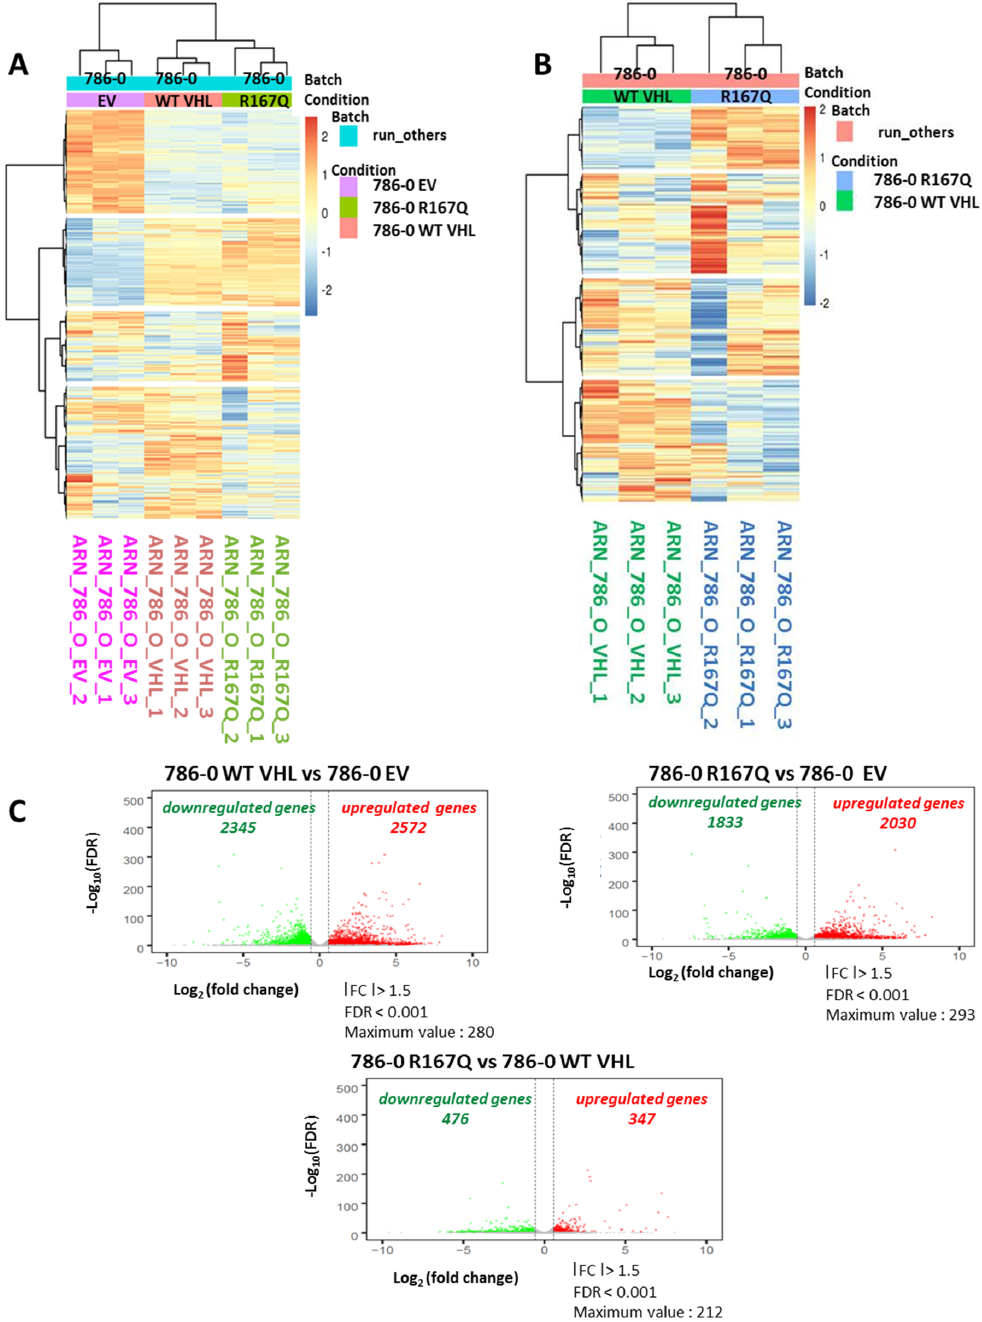
Figure 3. RNA-Seq analysis revealed discrete transcriptional differences between WT VHL and VHL-R167Q. ( A ): Heatmap from RNA-Seq analysis comparing 786-EV, 786-0 WT VHL, and 786-0 VHL-R167Q cells in triplicate. ( B ): Heatmap from RNA-Seq analysis comparing 786-0 WT VHL and 786-0 R167Q in triplicate. ( C ): Volcano plot of genes differentially expressed (Log 10 fold change). Genes differentially expressed in 786-0 WT VHL vs. 786-0 EV, in 786-0 R167Q vs. 786-0